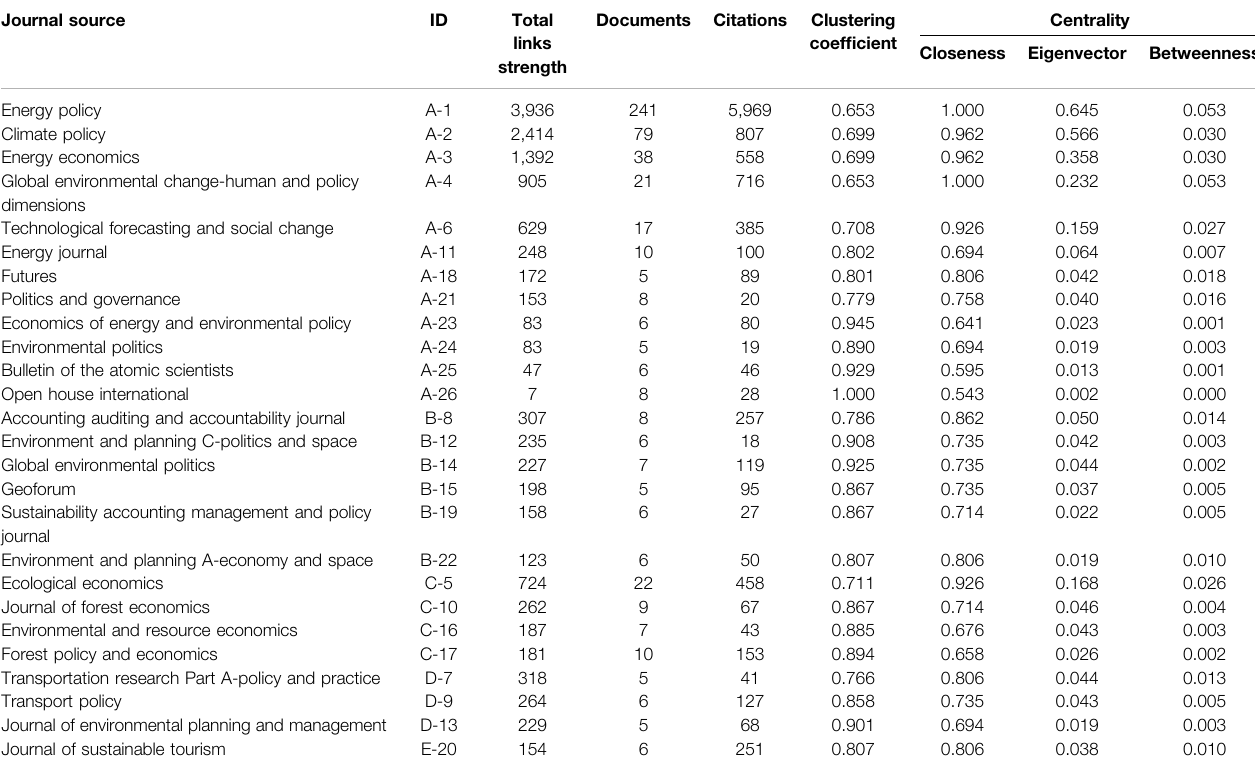
TABLE 5 | Main journal sources: key scientometric